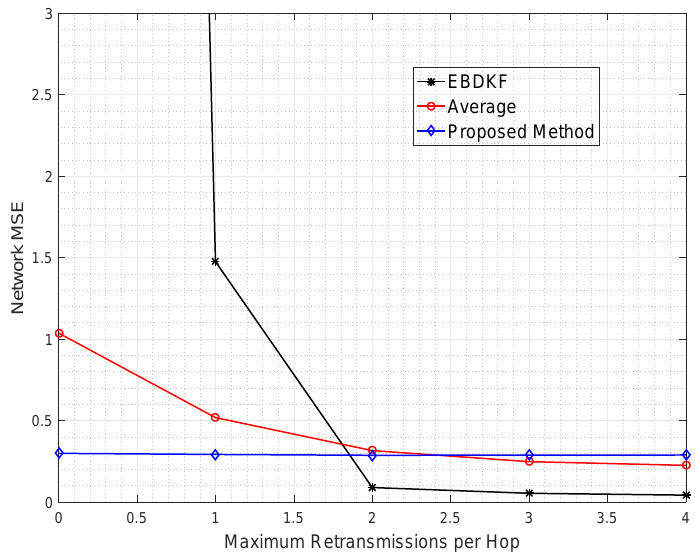
Figure 16. Network MSE comparison among the proposed statistical, AVG, and EBDKF information fusion methods in a retransmission allowed tree structured network when BER is 0.05.